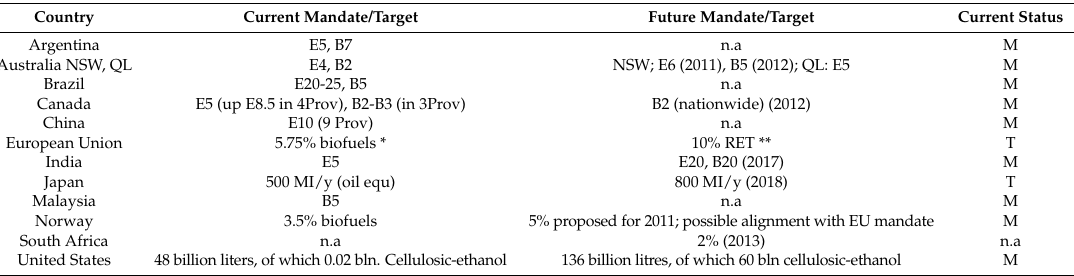
Table 3. Fuel ethanol blends in some countries.